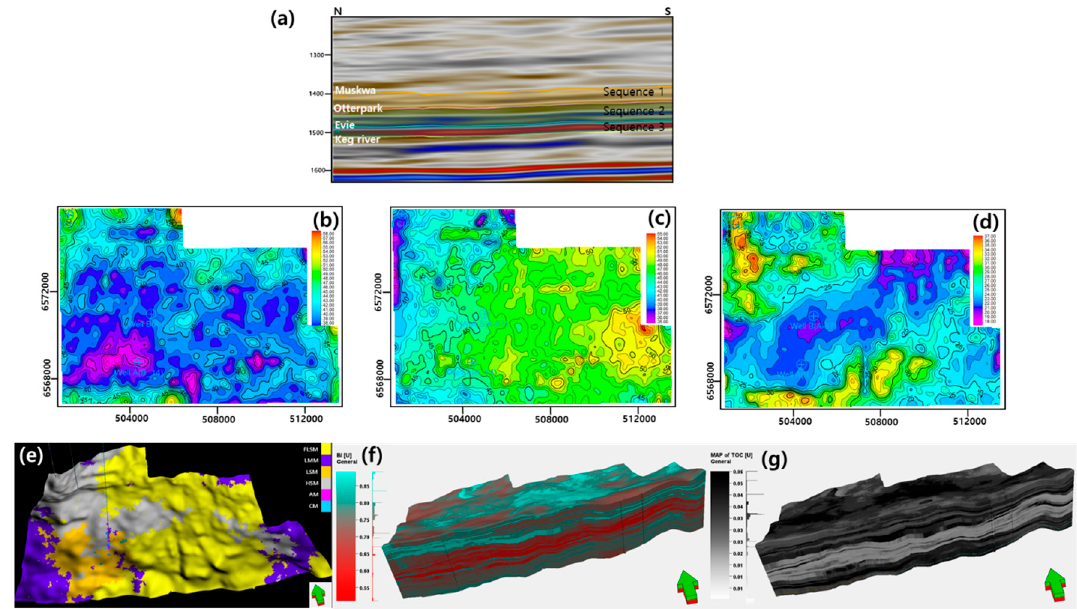
Figure 5. Seismic data interpretation results: ( a ) original seismic data, ( b ) time thickness map of Muskwa, ( c ) time thickness map of Otter Park, ( d ) time thickness map of Evie, ( e ) lithofacies modeling map of Muskwa, ( f ) petrophysical modeling map of brittleness index, and ( g ) petrophysical modeling map of the TOC.